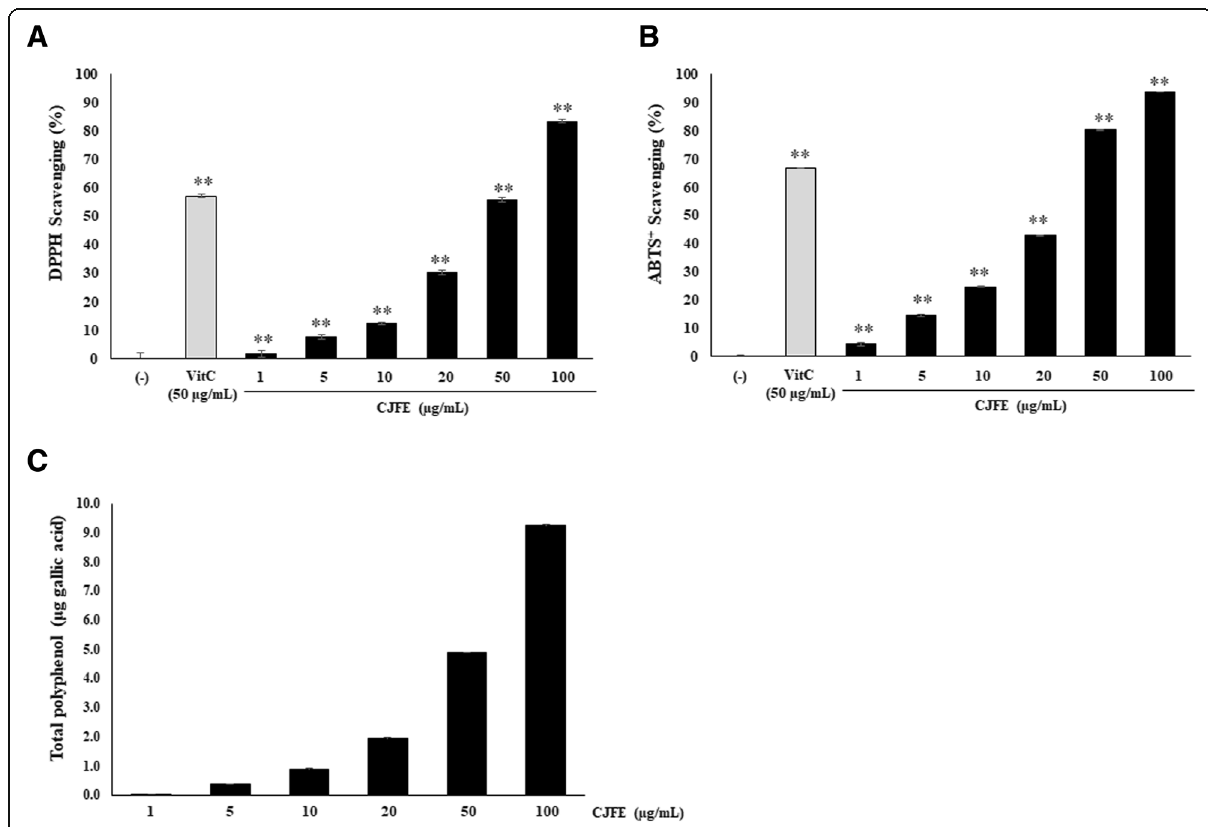
Fig. 2 The antioxidant effects of Camellia japonica flower extract. The antioxidant capacity and total phenolic content of CJFE were evaluated by DPPH ( a ) ABTS ( b ) and phenolic content assay ( c ). The results are mean ± standard deviation (SD) (n = 3). * P < 0.05, ** P < 0.01 vs. pollutant- untreated control. # P < 0.05, ## P < 0.01 vs. pollutant-treated